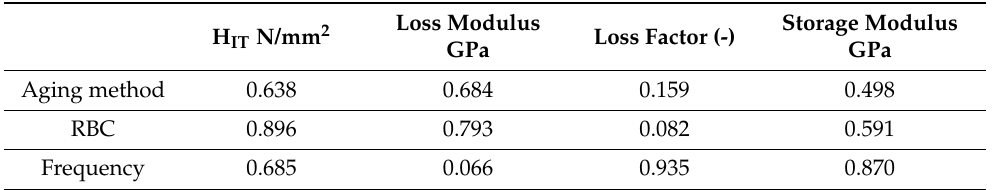
Table 3. Multivariate analysis (general linear model) and the effect strength of the main factors—aging method, RBC, and frequency—on the parameters tested. All effects were statistically significant ( p < 0.001); partial eta-squared ( η P2 ) values are given.